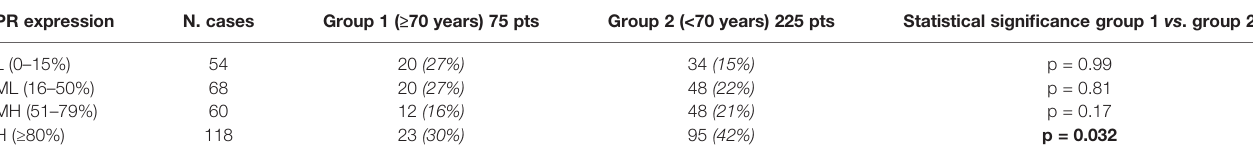
TABLE 1 | PR expression and patient age. PR